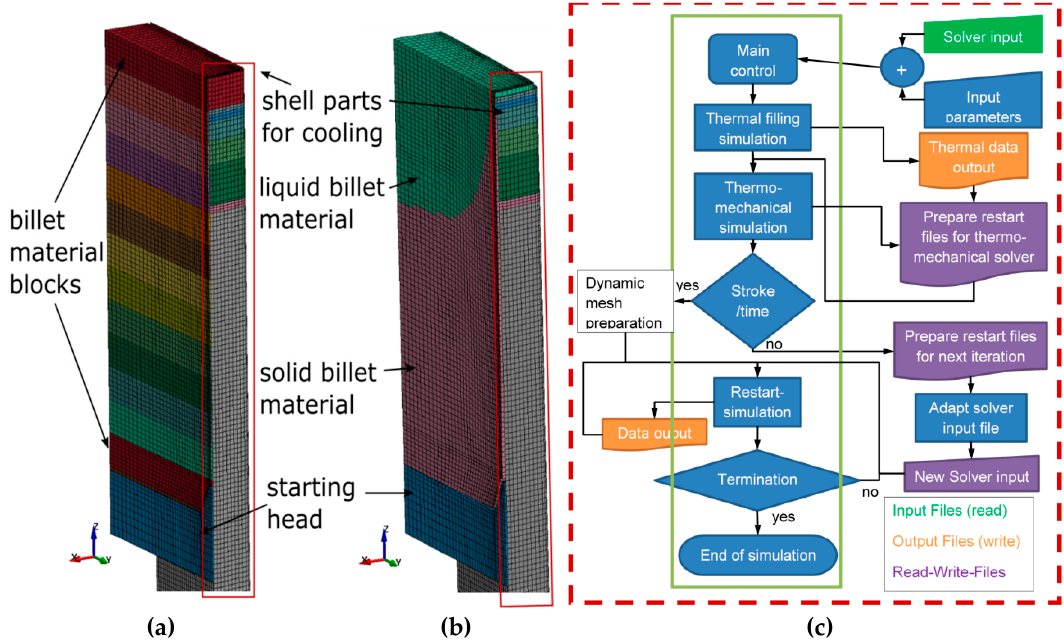
Figure 3. ( a ) Conventional BT model with its mesh-blocks for stepwise activation; ( b ) DMT mesh model with its continuous appended mesh layers at 1.4 m billet length; and ( c ) graphical algorithm representation for DMT implementation using Python script.